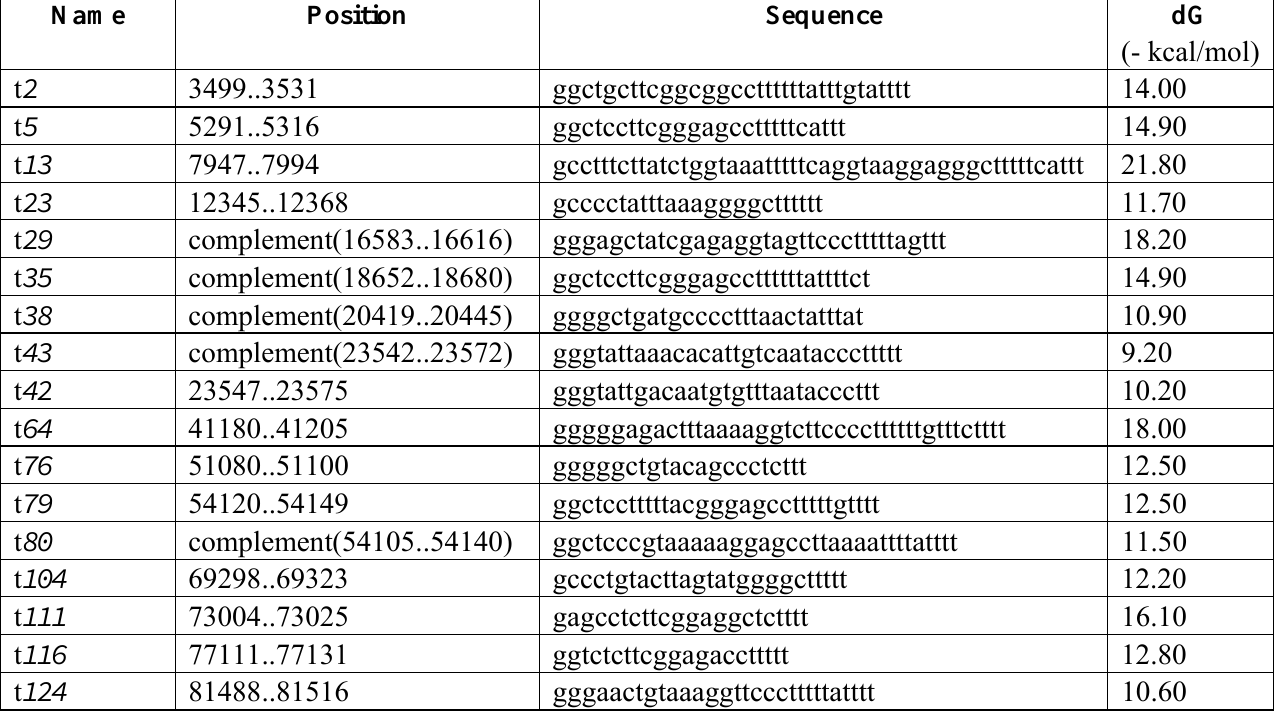
Table 2. Rho-independent terminators in the genome of Felix O1 predominantly discovered using TransTerm, with the structures verified using